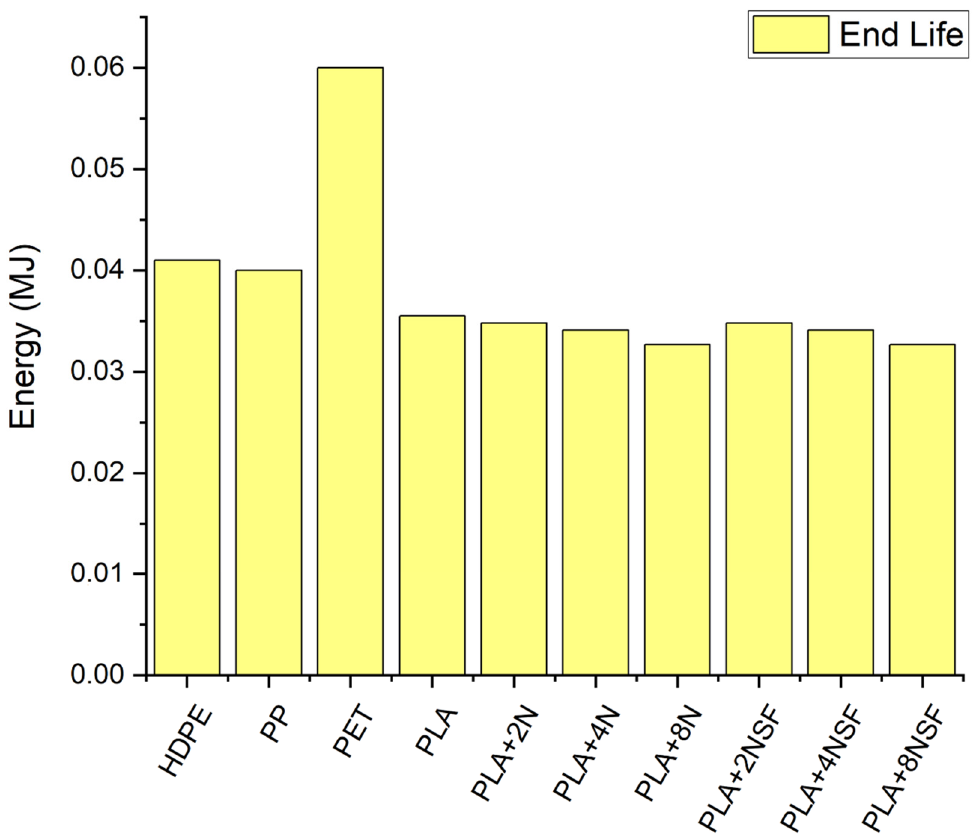
Figure 14. LCA results for end life in terms of energy.